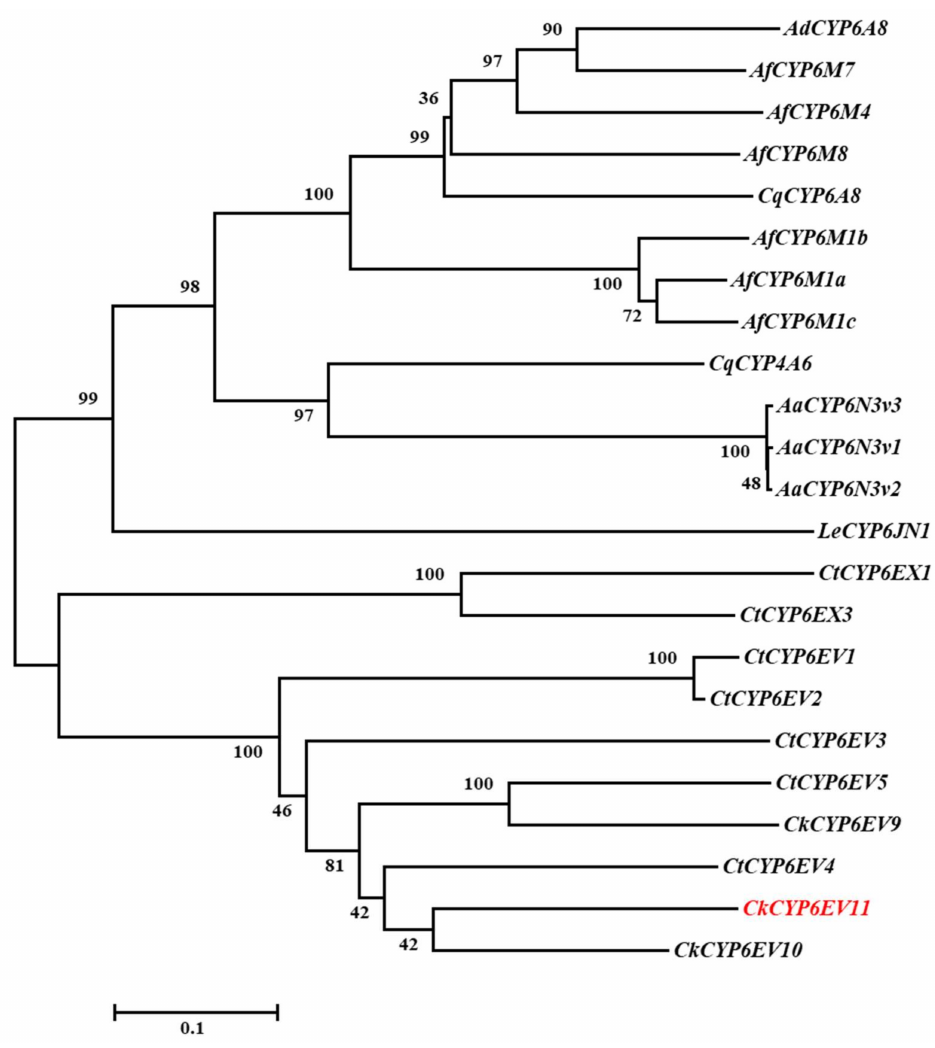
Figure 1. Phylogenetic tree of 23 CYP genes are from 7 insects. These genes were downloaded from the National Center for Biotechnology Information (NCBI) databases. The gene accession numbers are parenthesized. The CYP genes are CtCYP6EV1 (ARO50426.1), CtCYP6EV2 (ARO50430.1), CtCYP6EV3 (ARO50428.1), CtCYP6EV4 (ARO50429.1), CtCYP6EV5 (ARO50442.1), CtCYP6EX1 (ARO50434.1), CtCYP6EX3 (ARO50425.1), CkCYP6EV9 (AHJ10930.1), CkCYP6EV10 (AHJ10931.1), CqCYP4A6 (XP_001867280.1), CqCYP6A8 (XP_001870174.1), AaCYP6N3v1 (AAF97936.1), AaCYP6N3v2 (AAF97937.1), AaCYP6N3v3 (AAF97938.1), AdCYP6A8 (ETN65670.1), AfCYP6M1a (AFM08393.1), AfCYP6M1b (AFM08394.1), AfCYP6M1c (AFM08395.1), AfCYP6M4 (AFM08397.1), AfCYP6M7 (AIE17403.1), AfCYP6M8 (AFM08398.1), LeCYP6JN1 (ALX81394.1), CkCYPEV11 . CkCYP6EV11